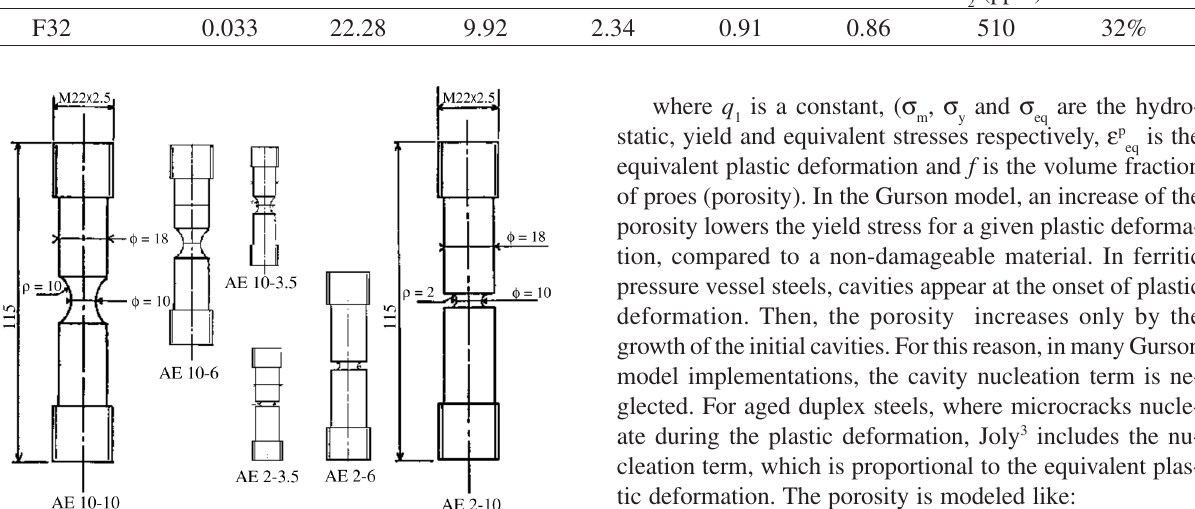
Table 1. Chemical Composition and ferrite content of material. Material